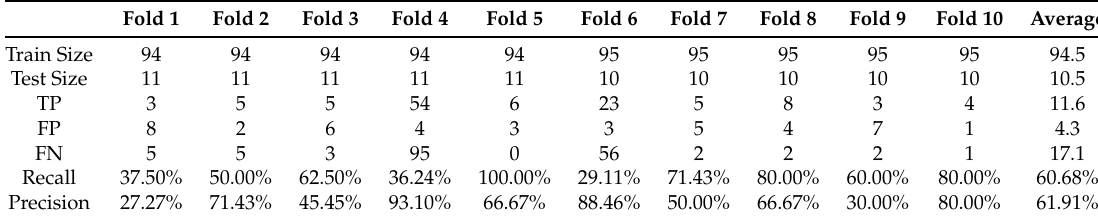
Table A11. The Results of Experiment 11: Adding images without dents (Dataset 1), by testing with a pre-classifier.